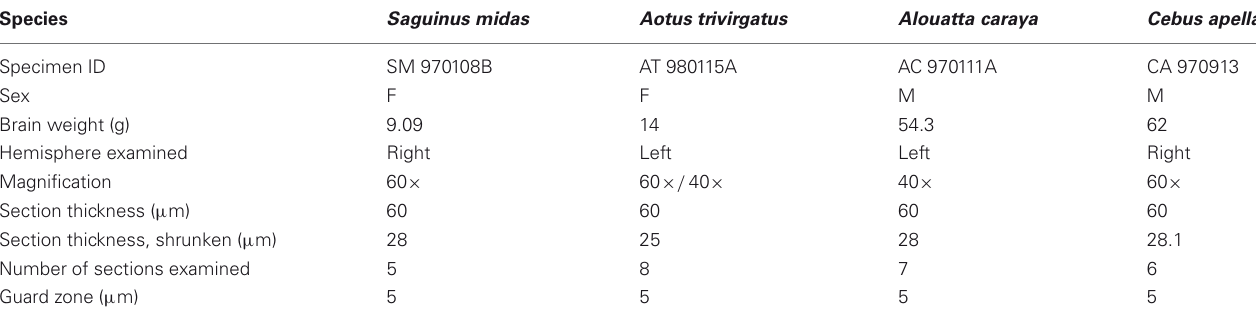
Table 1 | Species data for New World monkeys specimens used in stereological measurement of neuron density and layer II and III soma size.